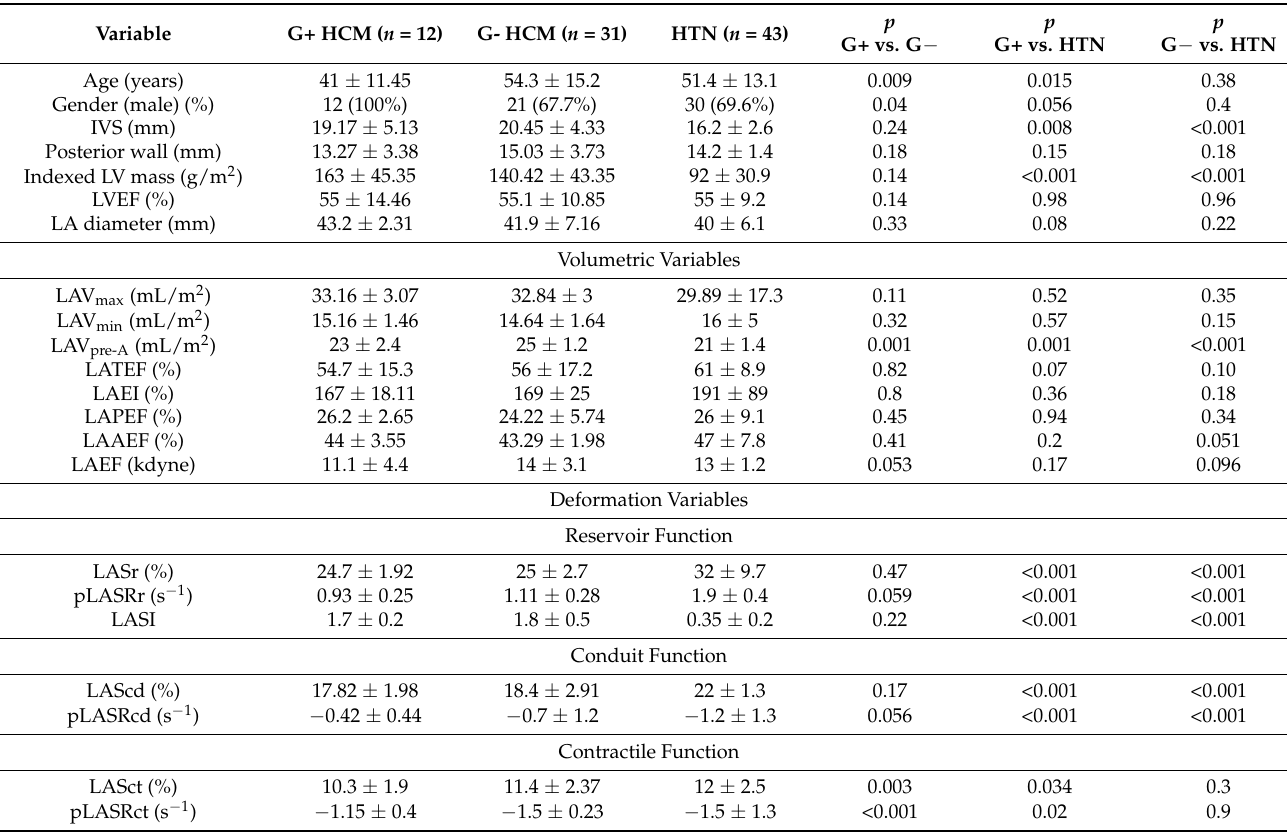
Table 3. Comparation of left-atrial (LA) strain parameters across HCM subjects with (G+) or without (G − ) pathogenic (P)/likely pathogenic (LP) variants and hypertensive subjects with left-ventricular hypertrophy (LVH).